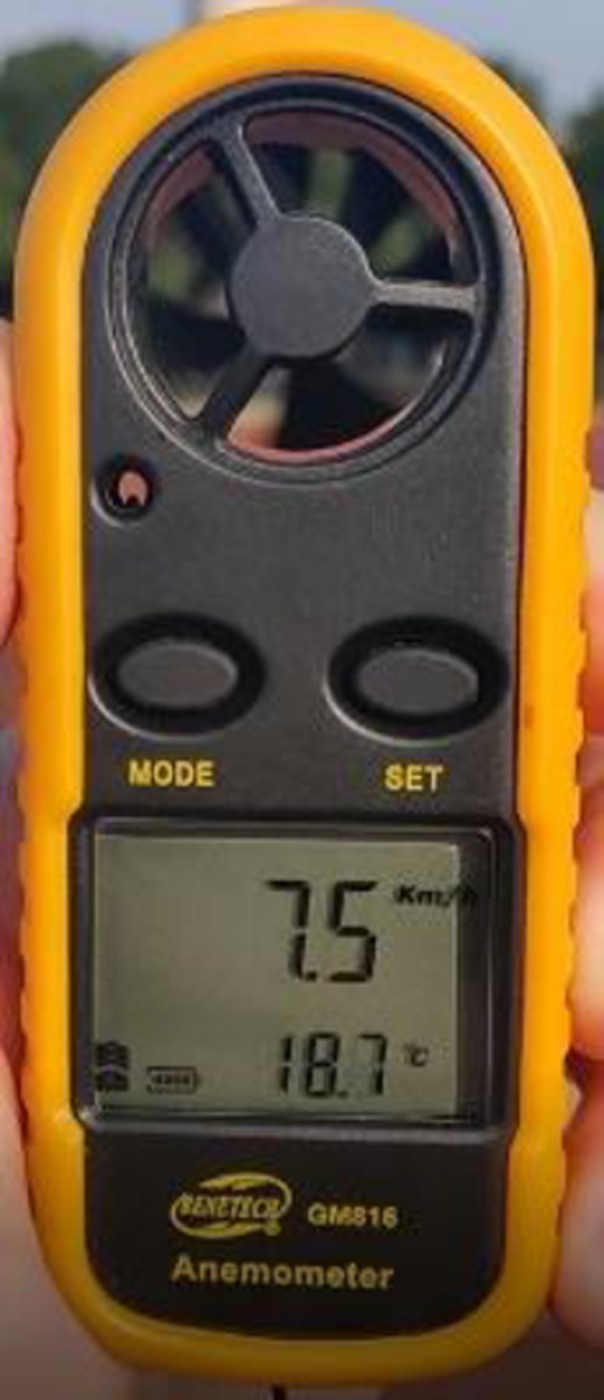
An anemometer used in the experiments.